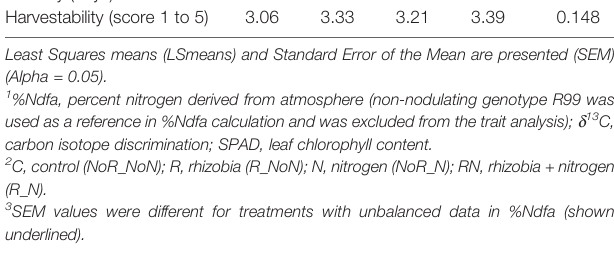
Least Squares means (LSmeans) and Standard Error of the Mean are presented (SEM) (Alpha =